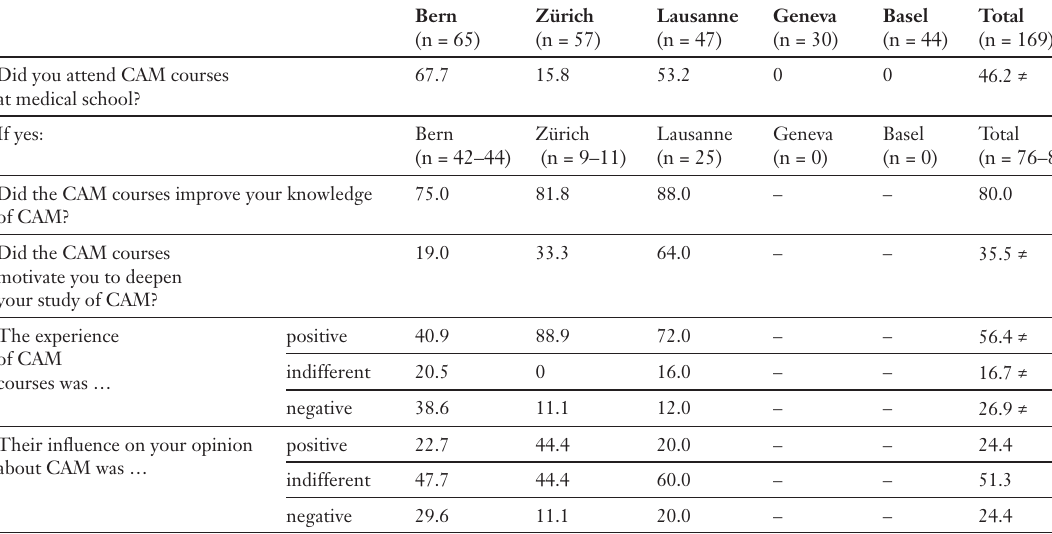
Students’ experience of CAM courses at medical school (%